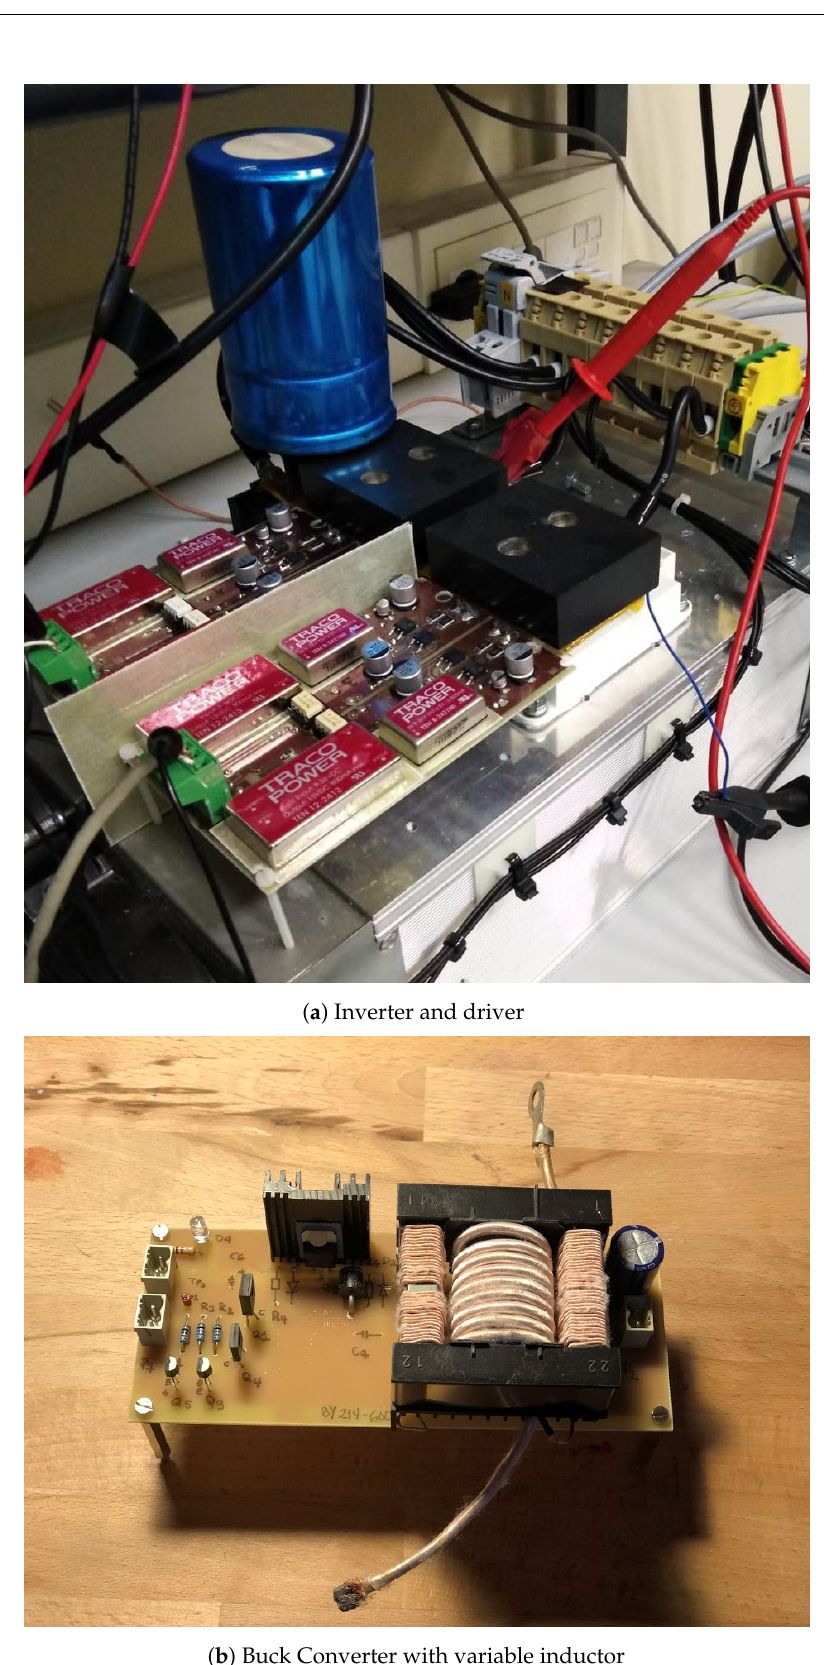
Figure 17. Inverter and